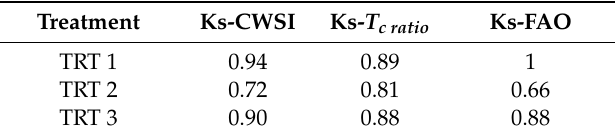
Figure 7. K s obtained by using CWSI , T c ratio , and soil moisture data for ( a ) TRT 1, ( b ) TRT 2, and ( c ) TRT 3 from 6 to 29 August 2017. The depths (mm) of individual irrigation (I) and precipitation (P) events are plotted as vertical bars. Table 3. Mean values of Ks-CWSI , Ks-T c ratio , and Ks-FAO for each irrigation treatment from 6 to 29 August 2017.